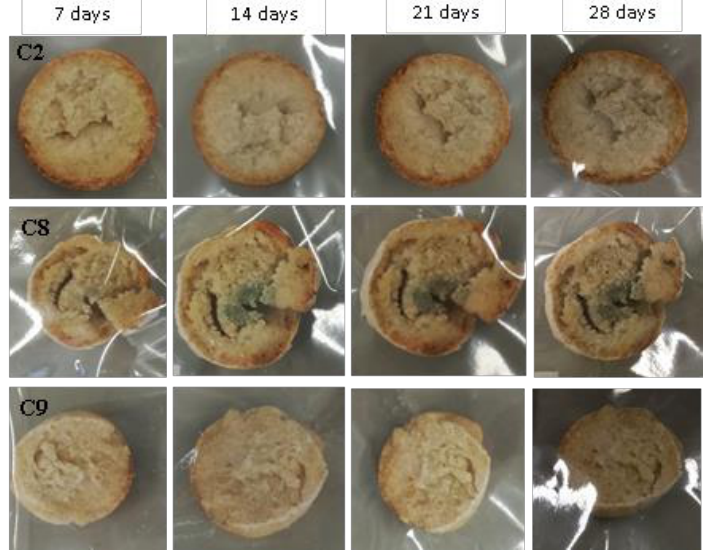
Figure 11. Examples of bread made from sourdoughs inoculated with the combination of isolates C2, C8, and C9, and then artificially contaminated with Fusarium culmorum and incubated at room temperature for 7, 14, 21, and 28 days.